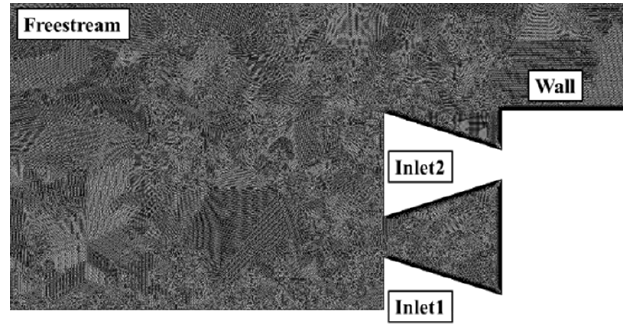
Table 8. Boundary conditions for validation [16].